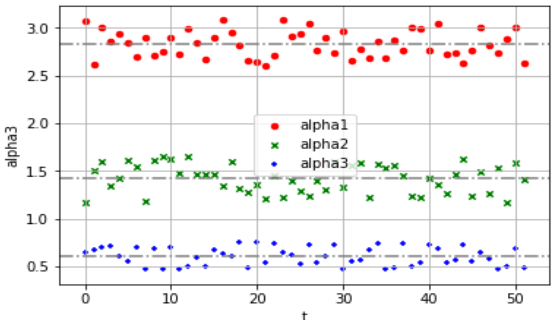
Figure 6. Alpha parameters learning result.